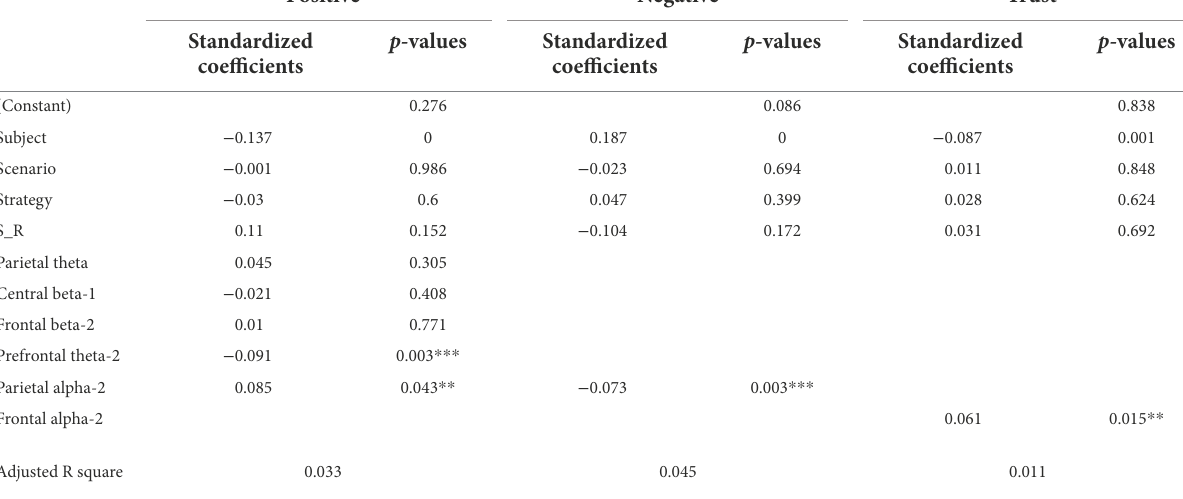
TABLE 8 EEG activity contributing to emotions and